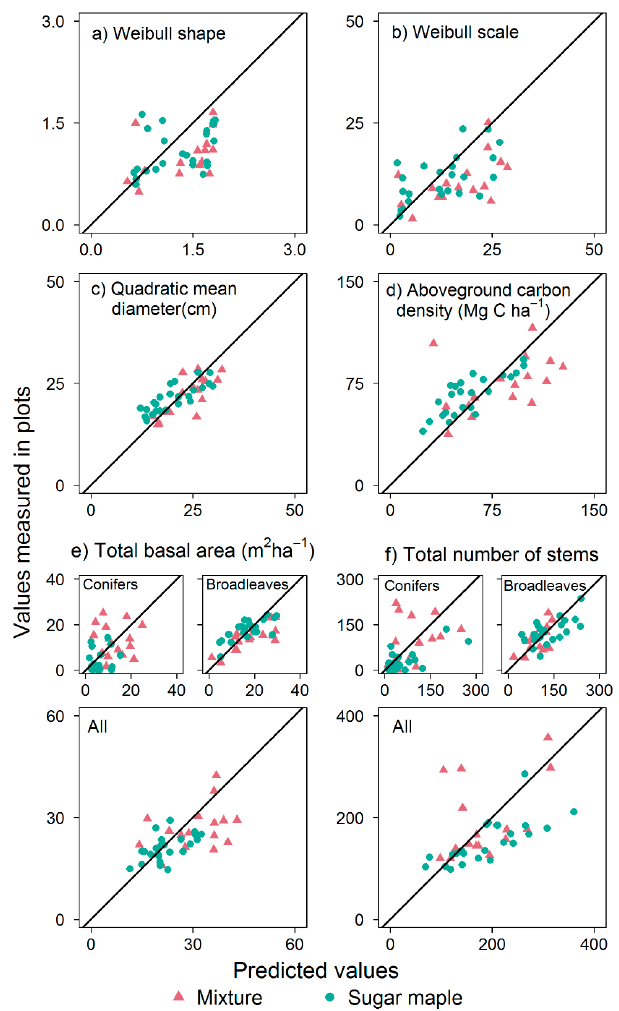
Figure 5. Predictions of stand attributes versus the measured values in validation plots for ( a ) Weibull